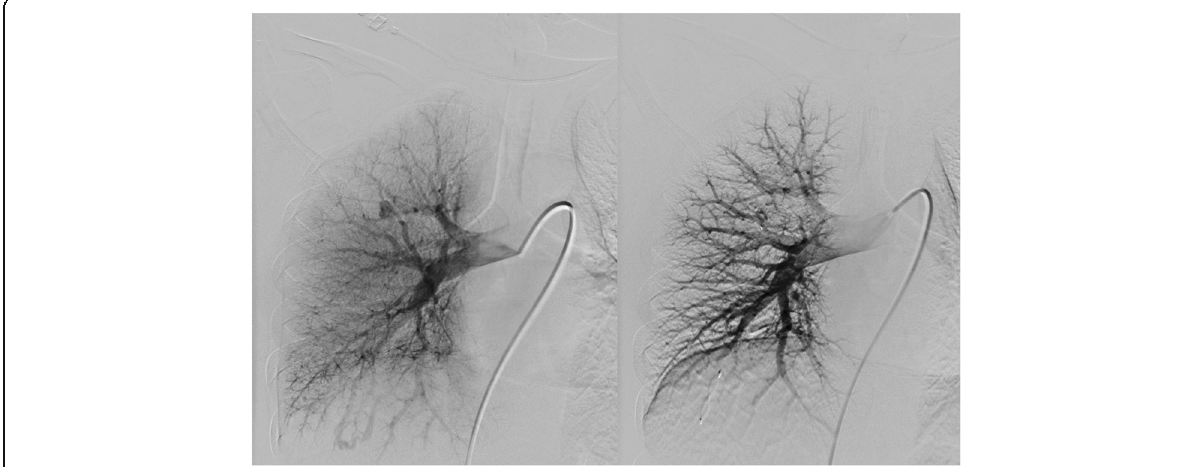
Fig. 6 Pulmonary angiography before and after embolization of both PAVMs in the right lung. The PAVM in upper lobe was embolized with